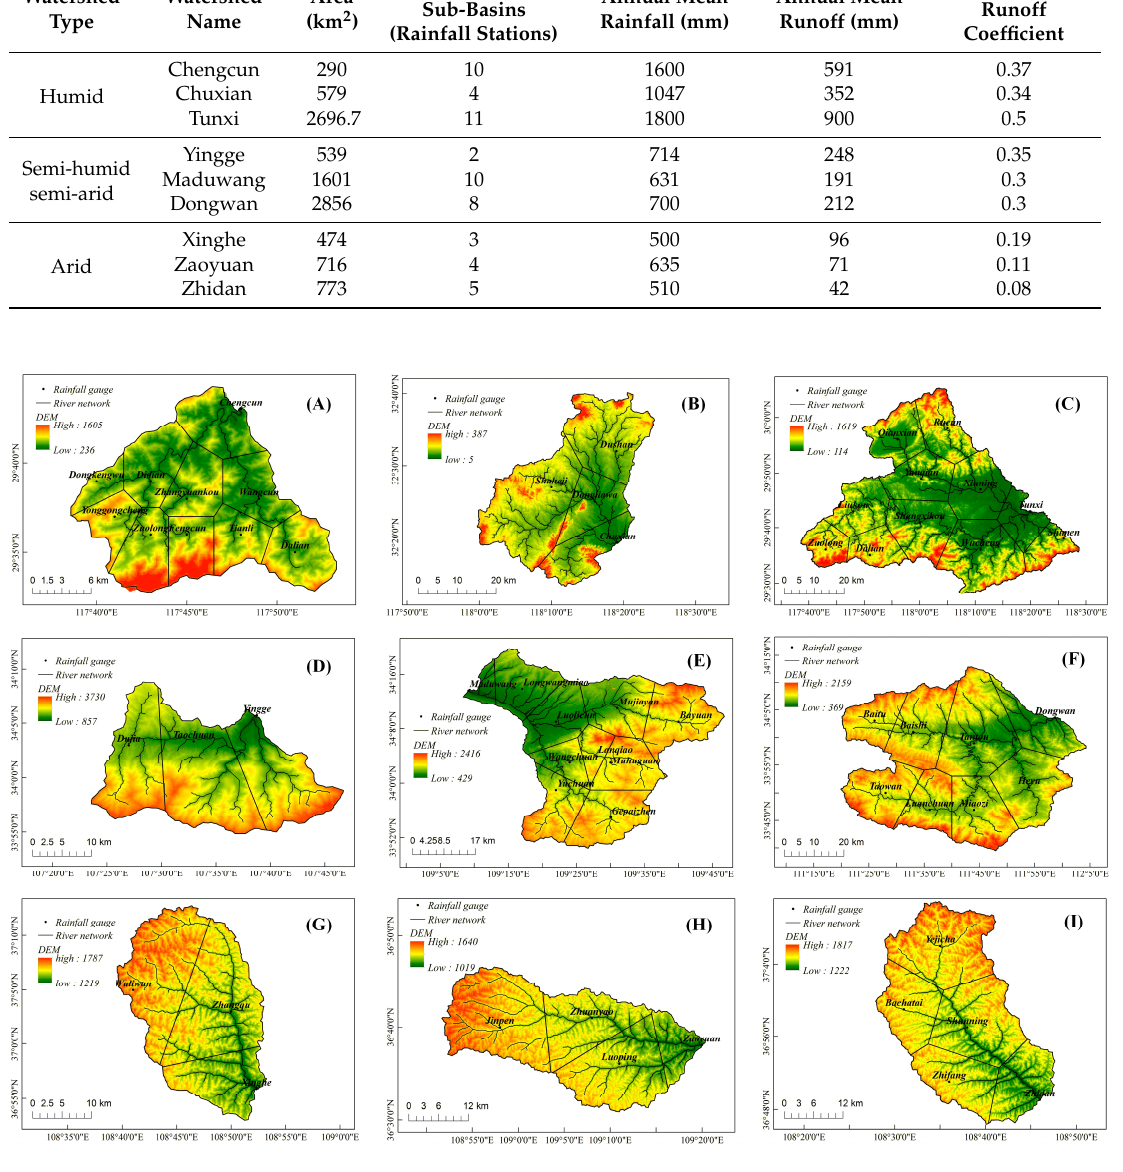
Figure 1. Map of the nine study watersheds. ( A ) Chengcun; ( B ) Chuxian; ( C ) Tunxi; ( D ) Yingge; ( E